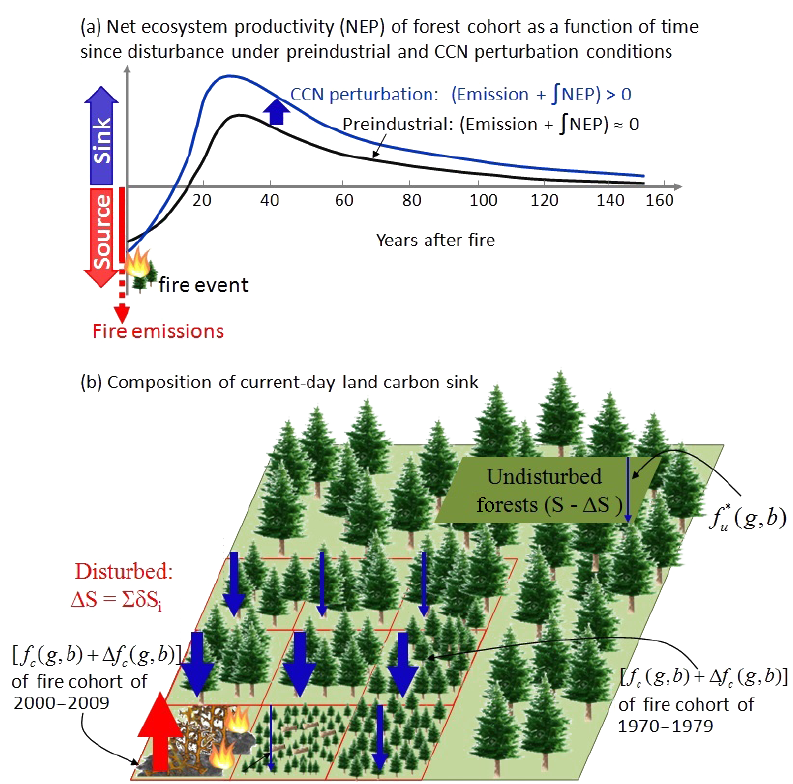
Figure 1. Panel (a) : the evolution of forest net ecosystem productivity (NEP) with the time since disturbance after fire under preindustrial conditions and as impacted by the CCN (climate, atmospheric CO 2 , nitrogen deposition) perturbations. Under preindustrial conditions, the net carbon balance over the fire cycle is close to zero and is a carbon sink under CCN perturbations. Panel (b) : the contemporary carbon balance of a geographical point (with a total area of S) for the 2000–2009 decade is composed of three components: carbon fluxes from forest cohorts as legacies of past decadal fires, fire carbon emissions within the 2000–2009 decade (with cumulative fire-disturbed area being (cid:49)S ), and carbon fluxes from undisturbed mature forests (with area being S − (cid:49)S ). The nature (sink or source; blue or red arrow) and size (the width of arrows) of carbon balance of fire cohorts of different ages are shown quantitatively in the figure. The mathematical symbols for the carbon fluxes of the fire cohorts of the decades 2000–2009 and 1970–1979 and those from undisturbed mature forests are indicated; the symbols are the same as in Eq. (2) in the text. Note that, for clarity, the flux under preindustrial conditions ( f c (g,b) ) and the additional flux caused by CCN perturbations ( (cid:49)f c (g,b) ) are not separated for all (red and blue) arrows that represent carbon